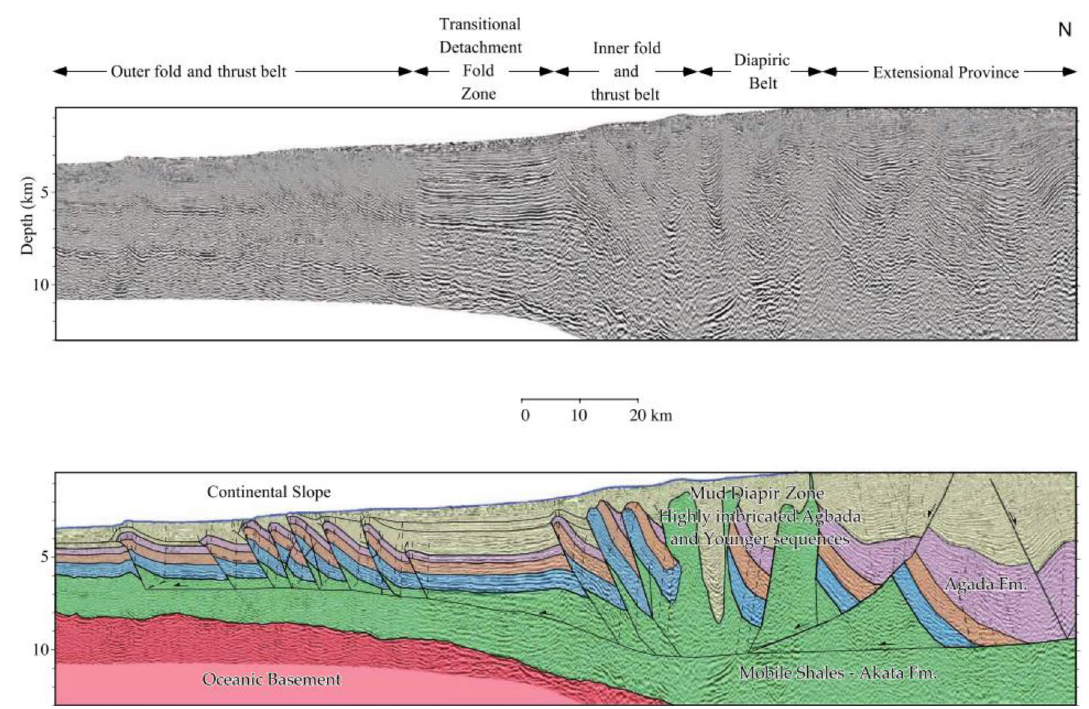
Fig. 3 Uninterpreted and interpreted regional seismic profile across the Niger Delta showing the structural zones (Corredor et al. 2005) Table 1 Summary of the available data set for each of the studied wells